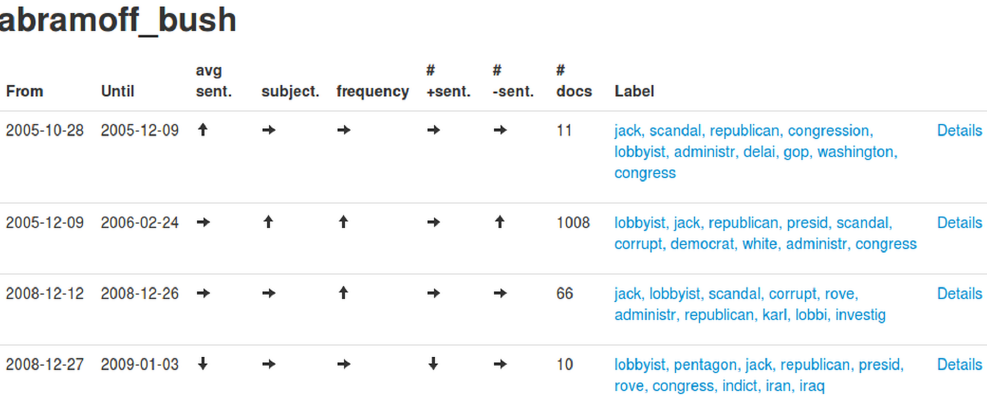
Figure 5. List of detected events for the topic “abramoff bush”.